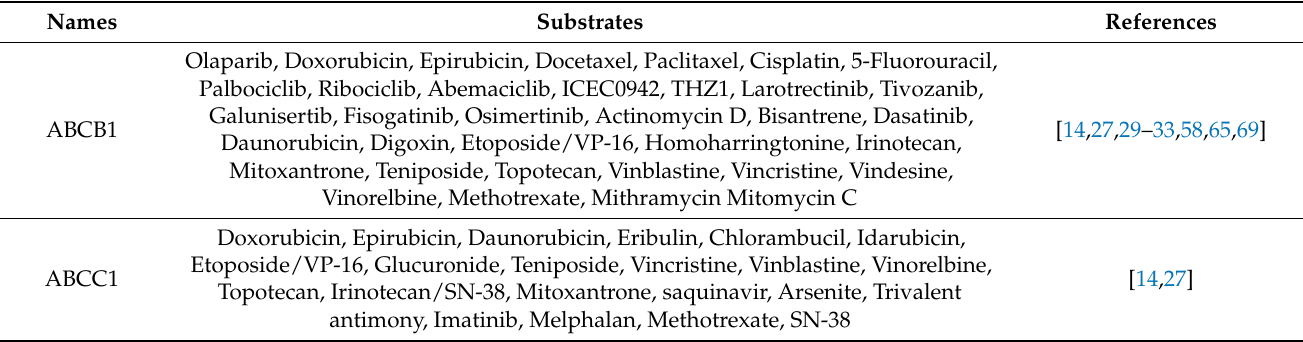
Table 1. Anticancer drug substrates of the ATP-Binding Cassette (ABC)